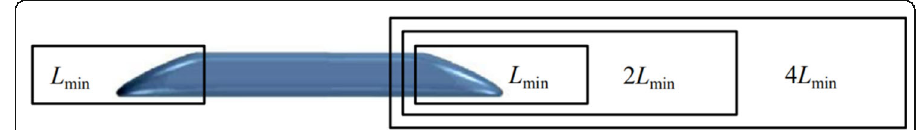
Fig. 3 Diagrammatic sketch of the volume mesh refinement near the